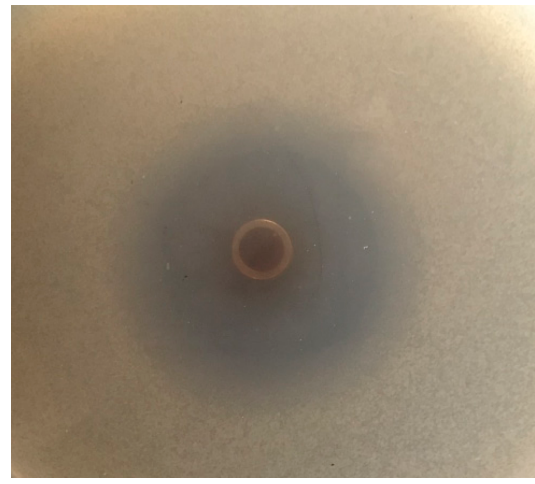
Figure 4. The optimal medium of fermentation broth against the inhibition zone diameter of Staphylococcus aureus .